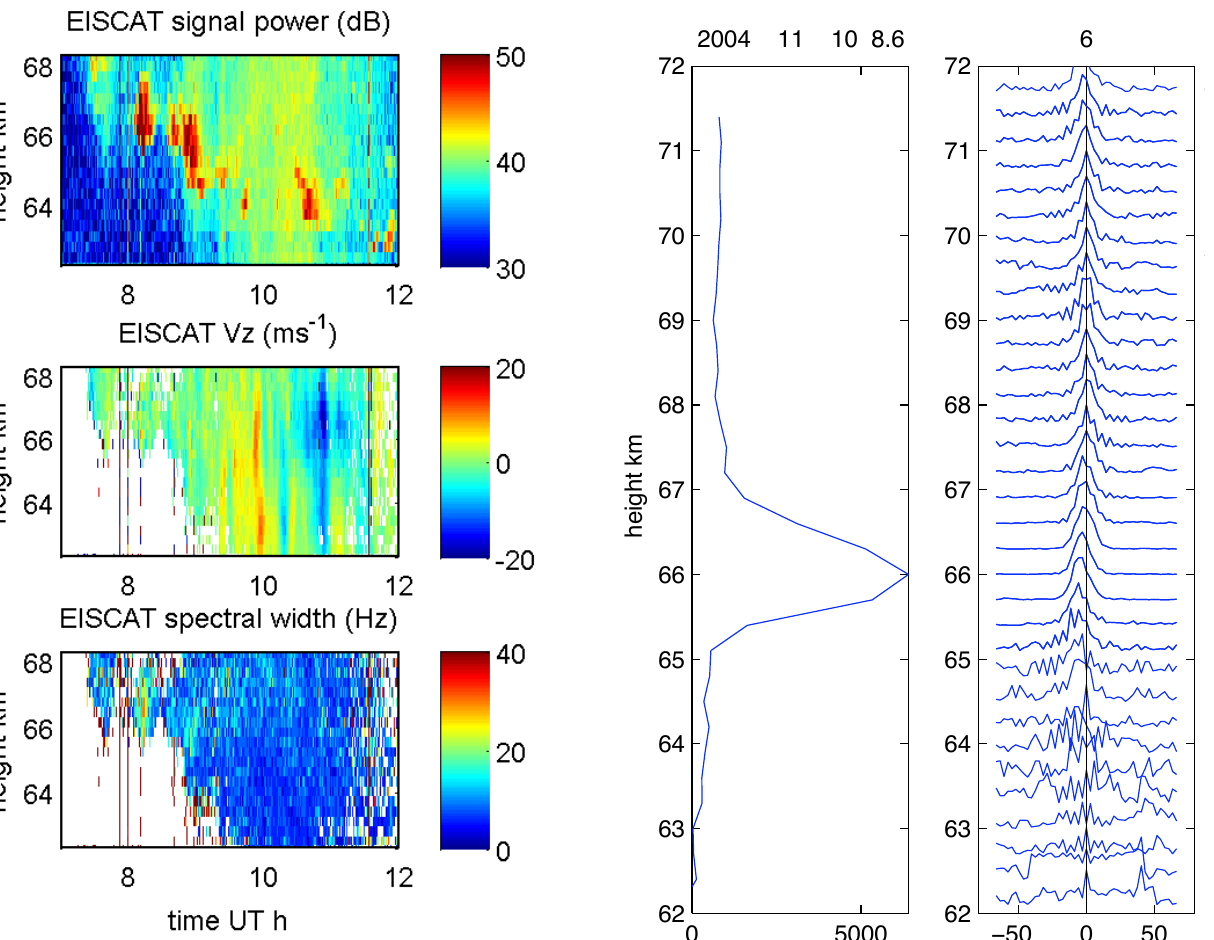
Fig. 2. EISCAT observations covering the strong PMWE event in the pre-noon sector. Upper panel shows radar echo strength, middle panel shows echo Doppler shift (positive towards the radar), lower panel shows echo spectral width (all 30s integrated data).